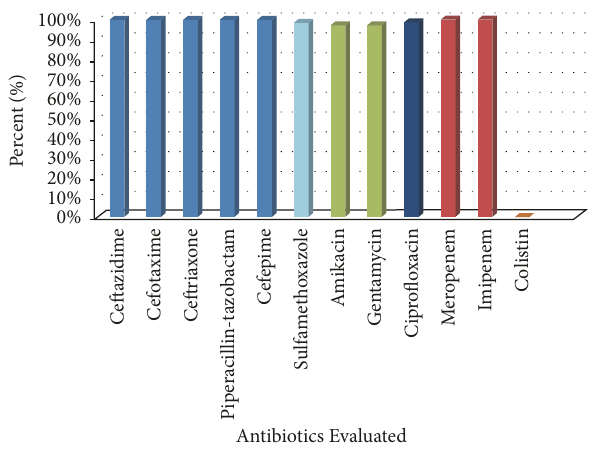
Figure1:Histogramshowingthepercentresistanceof Acinetobacter isolates to each antibiotic tested according to the CLSI guidelines.